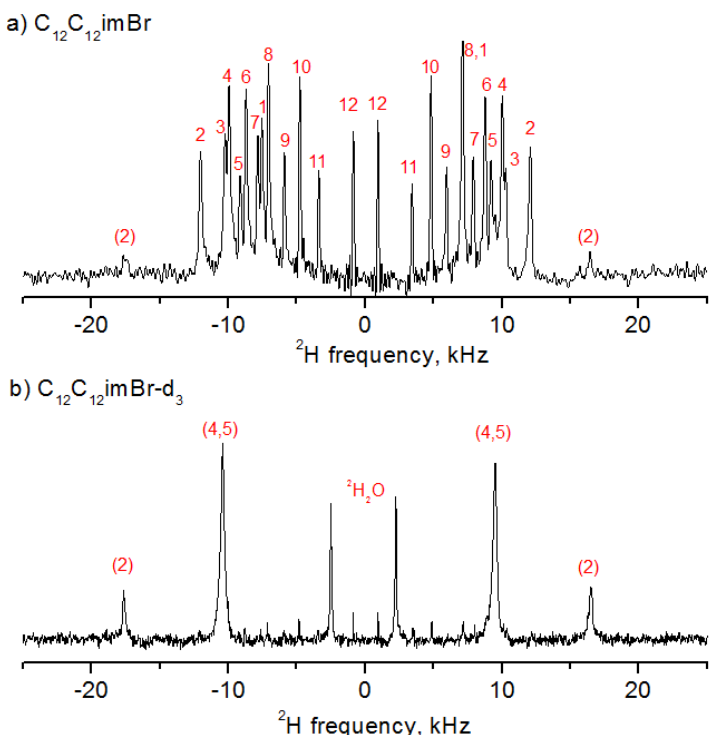
Figure 4. ( a ) Natural abundance deuterium (NAD) NMR spectrum of C 12 C 12 imBr at 102 ◦ C. The spectrum resulted from the accumulation of 380 k scans during 32 h of experimental time. ( b ) 2 H NMR spectrum of C 12 C 12 imBr-d 3 sample enriched with 2 H in the imidazolium ring at 102 ◦ C. About 3 weight percent of the 90% deuterium-labelled material was added to the C 12 C 12 imBr sample with natural isotopic abundance.